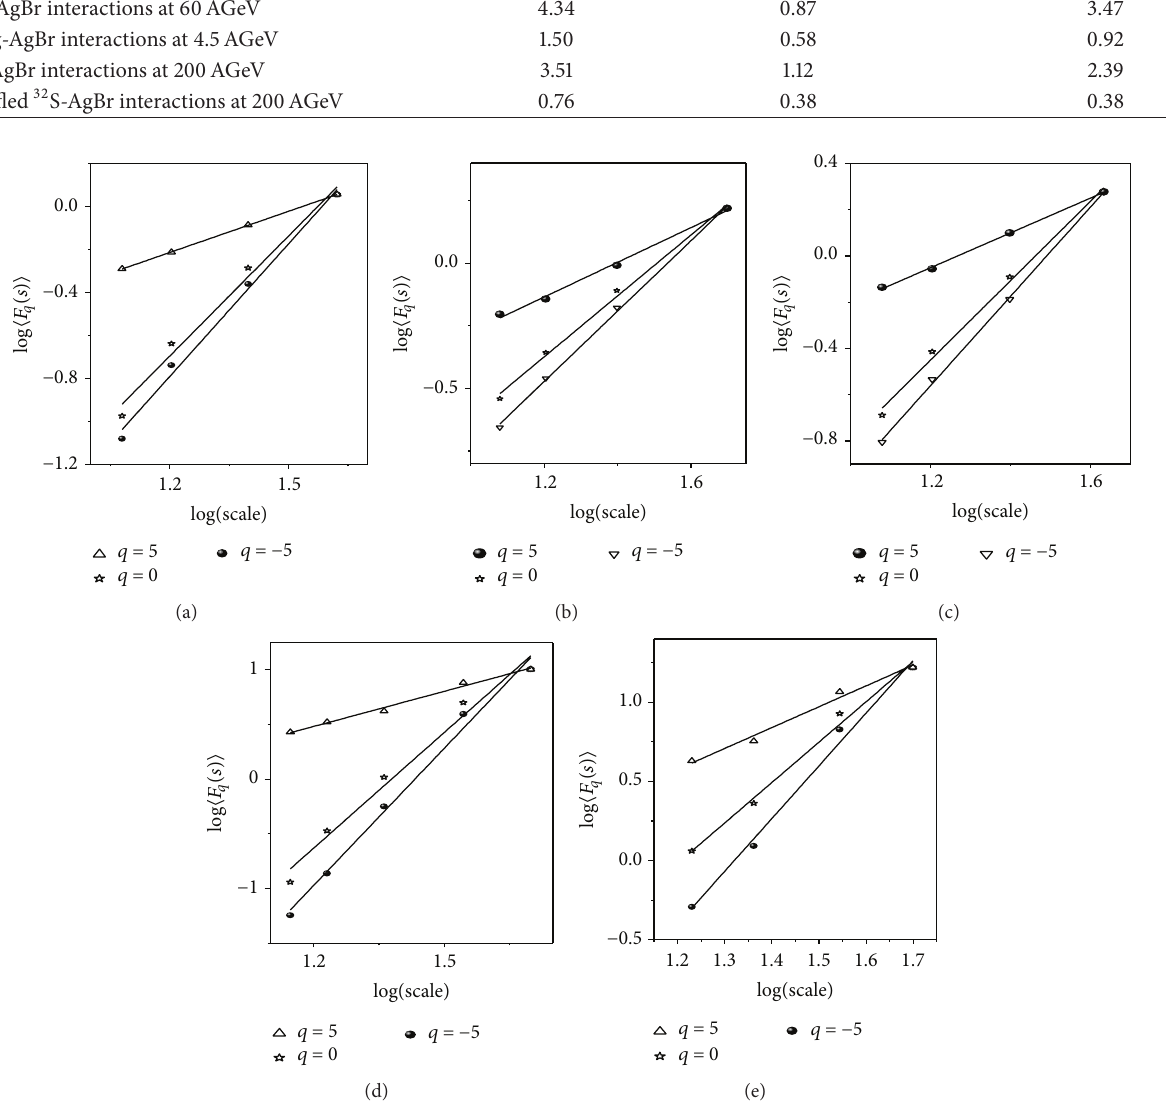
Figure 1: Plot of logarithm of fluctuation function with logarithm of scale for (a) 12 C-AgBr interactions at 4.5 AGeV, (b) 24 Mg-AgBr interactions at 4.5AGeV, (c) 16 O-AgBr interactions at 2.1AGeV, (d) 16 O-AgBr interactions at 60 AGeV, and (e) 32 S-AgBr interactions at 200